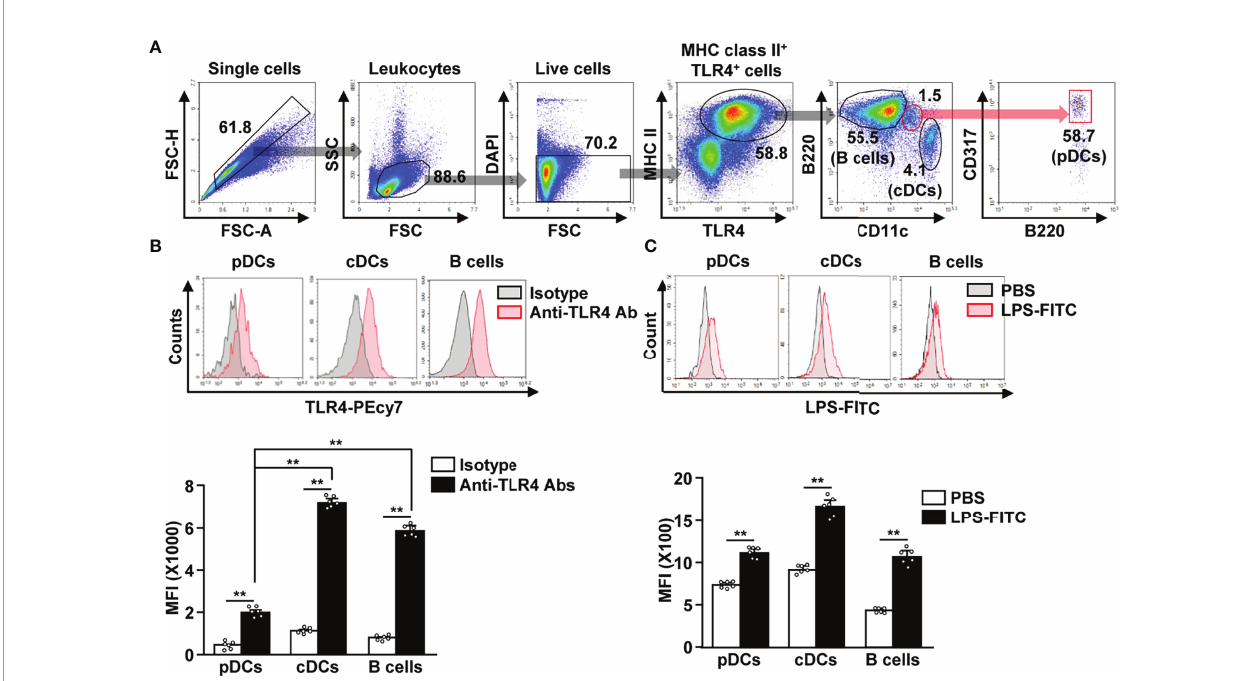
FIGURE 1 | Lipopolysaccharide (LPS) bound to the plasmacytoid dendritic cells (pDCs), conventional DCs (cDCs), and B cells in mice. (A) Toll-like receptor 4 (TLR4)-expressing major histocompatibility complex (MHC) class II positive cells were shown. (B) TLR4 expression in pDCs, cDCs, and B cells was analyzed by fl ow cytometry (upper panel). Mean fl uorescence intensity (MFI) of TLR4 expression levels in pDCs, cDCs, and B cells is shown (lower panel) (n = 6 mice, two-way ANOVA, mean±SEM, **p < 0.01 ). (C) Binding of FITC-conjugated LPS to pDCs, cDCs, and B cells was analyzed (upper panel). MFI of LPS-FITC binding to pDCs, cDCs, and B cells is shown (lower panel) (n = 6 mice, two-way ANOVA, mean±SEM, **p < 0.01